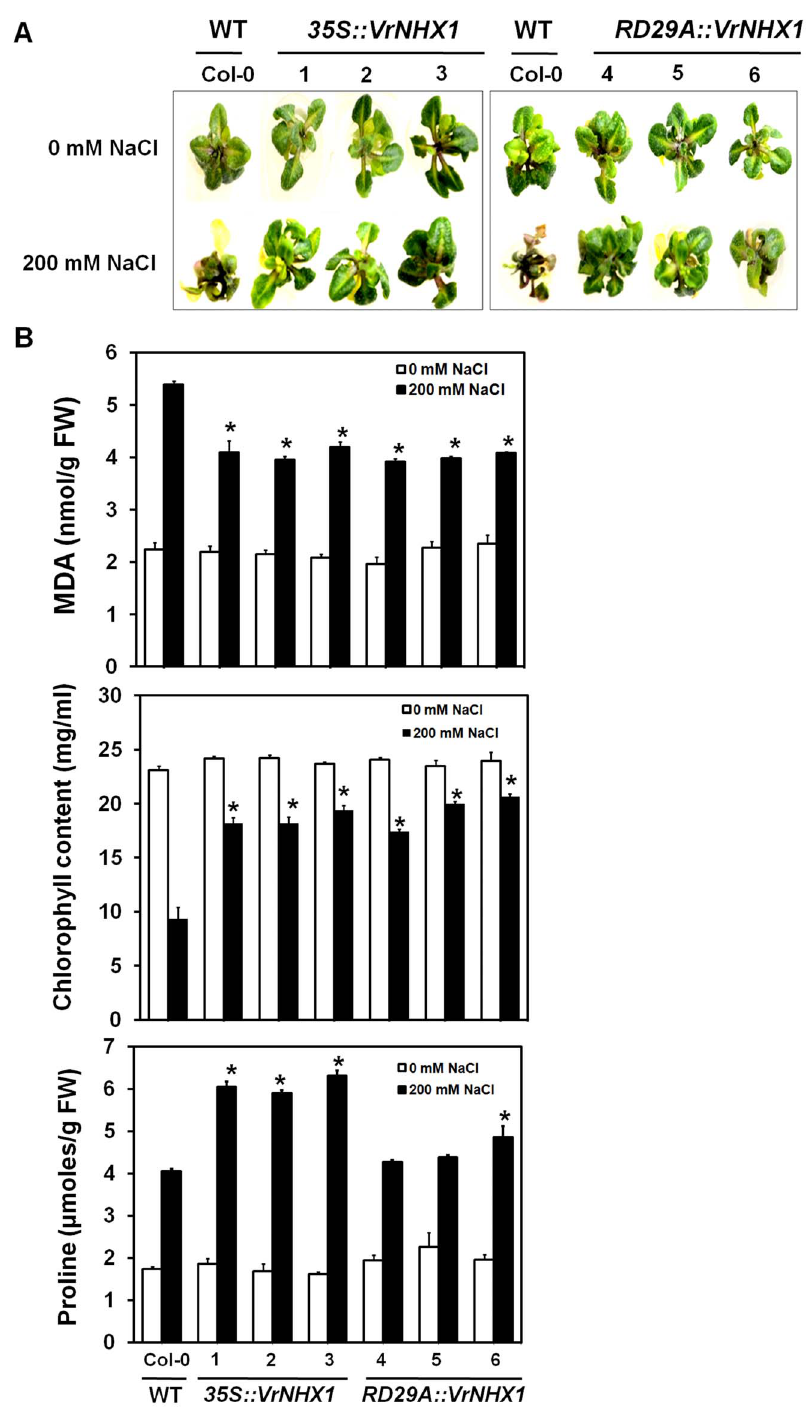
Figure 10. Studying the physiological changes in transgenic Arabidopsis lines under salt stress. (A) Effect of salt stress in wild type (WT, Col-0) and transgenic Arabidopsis lines expressing VrNHX1 constitutively (Lines 1–3, 35S:: VrNHX1 ) and inducibly (Lines 4–6, RD29A:: VrNHX1 ). NaCl- induced morphological changes was visible in 10 days old WT and transgenic lines after exposure to 200 mM NaCl for 5 days. (B) Changes in chlorophyll, MDA and proline content were estimated and analyzed as explained in materials and methods section. Values indicate means 6 SE (n=3). Statistically significant values at P # 0.05 are indicated as ‘‘*’’, using Bonferroni analysis. doi:10.1371/journal.pone.0106678.g010 Physiological response under salt stress, indicated higher Na + which displayed up-regulation under dehydration stress [13,42,54]. However, contrasting results have been reported for accumulation in roots than shoots in early and mid stage expression of PeNHX1 and AtNHX1 [48,52]. mungbean seedlings, in contrast to the reports in T. repens ,